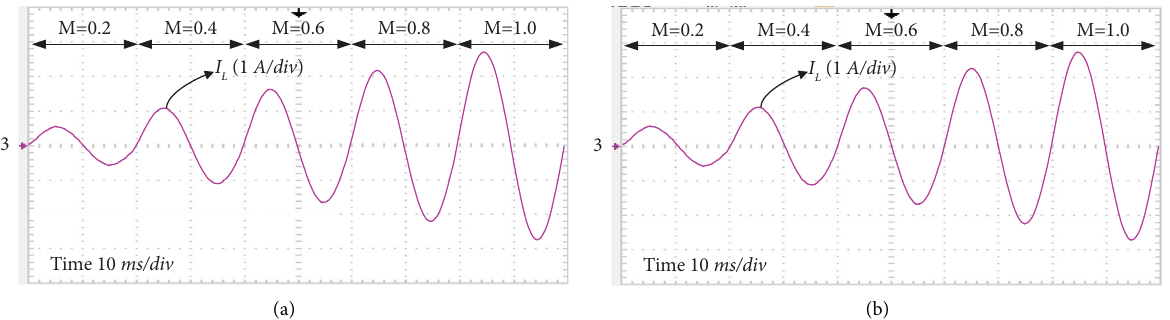
Figure 22: Experimental 11L CHB inverter load current for dynamic values of M . (a) SVPWM-I. (b) SVPWM-II.